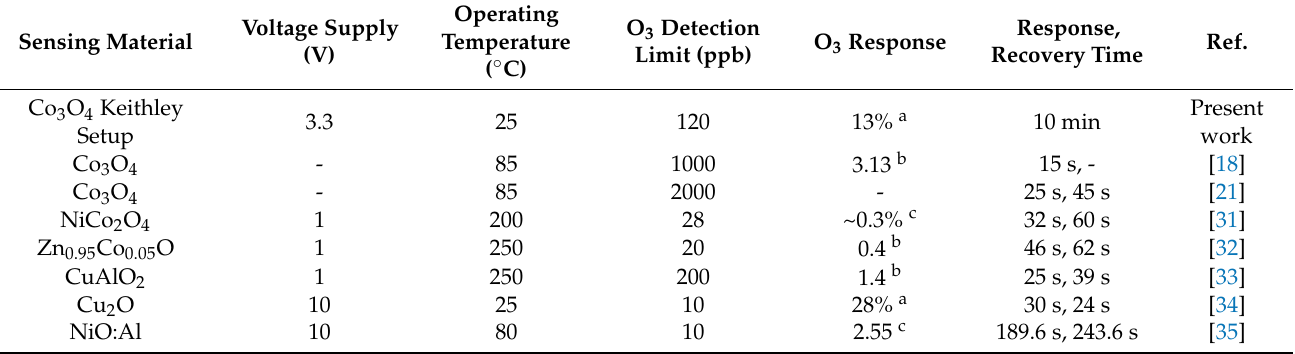
Table 4. Summary of MOS ozone sensors.